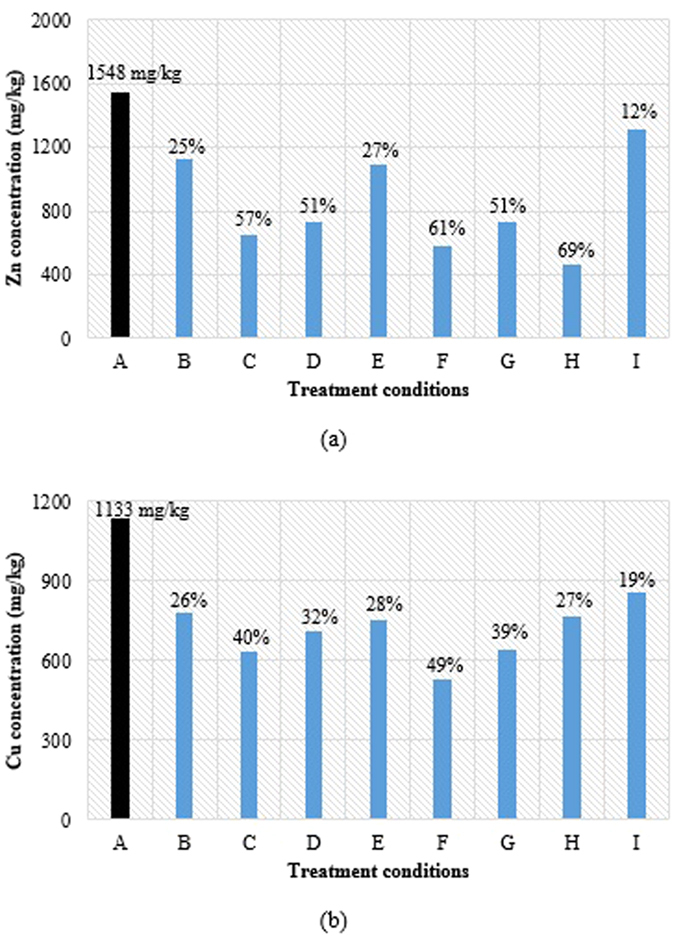
Impact of acidic conditions on (a) Zn and (b) Cu removal during EK (in terms of removal efficiency). A: Without EK treatment (raw secondary sludge). B: With EK treatment. C: With EK treatment and addition of HNO3 at pH 3. D: With EK treatment and addition of HNO3 at pH 4. E: With EK treatment and addition of HNO3 at pH 6–7. F: With EK treatment and addition of aqua regia at pH 3. G: With EK treatment and addition of EDTA + H2SO4 at pH 3. H: With EK treatment and addition of aqua regia + H2SO4 at pH 3.